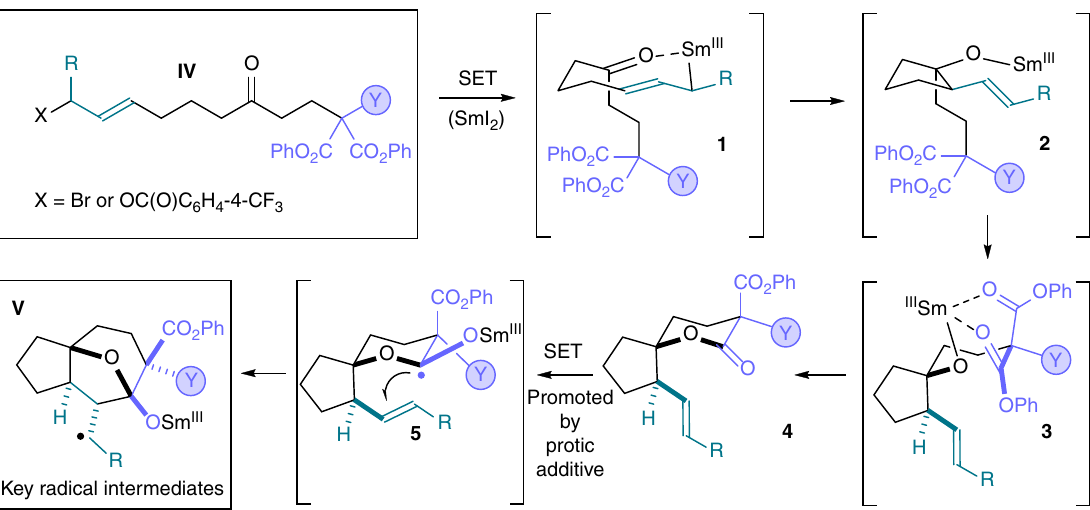
Key radical intermediates Fig. 2 Mechanistic platform for the radical folding cascades. A mechanism for the common stages of the samarium(II) folding cascades and the formation of the key radical intermediates V is shown. The sequence commences with an intramolecular, samarium(II)-mediated Barbier reaction to give alkoxides 2 which yield 4 after diastereoselective lactonisation. Addition of water then triggers lactone radical cyclisations involving radicals